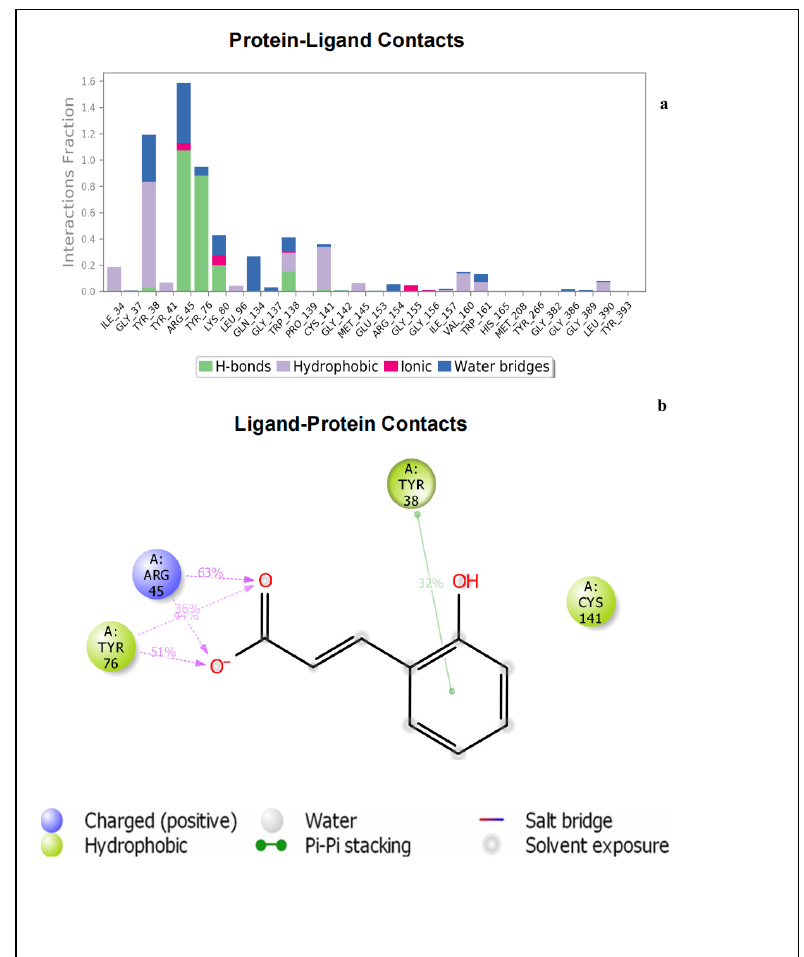
Figure 5. ( a ) Bar chart plot detailing protein-ligand interactions of p-coumaric acid-NorA complex with the key amino acid residues at NorA active site. ( b ) Simulation interaction diagram detailing the interaction of p-coumaric acid with NorA from 0–100 ns.